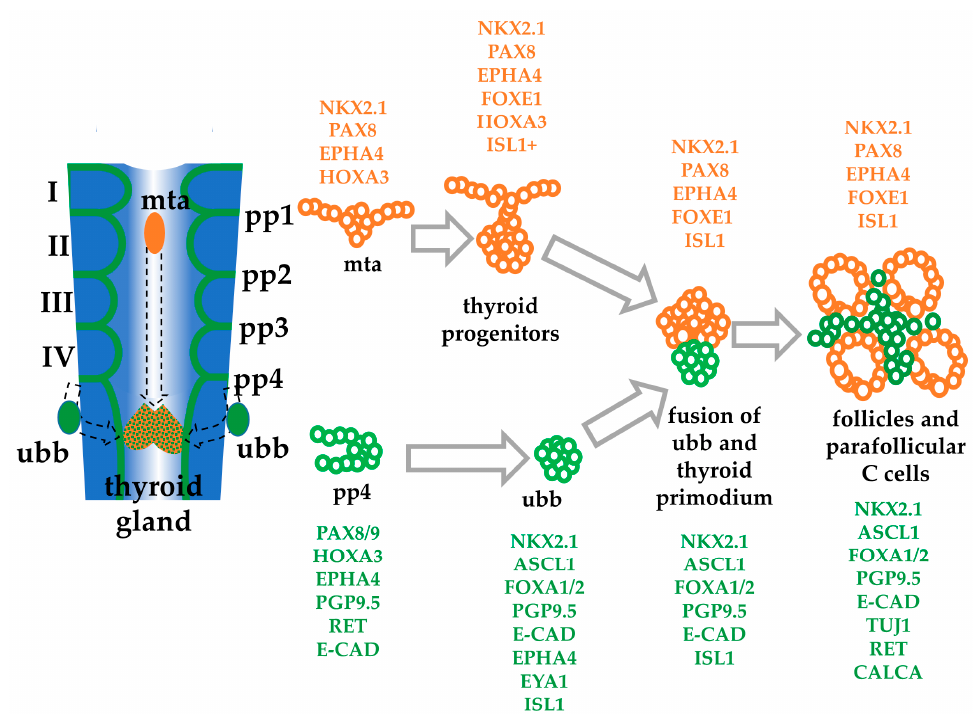
Figure 1. Development of the thyroid organ. Scheme of the development of the pharynx showing the origin and morphogenetic movements of the medial thyroid anlage (mta) from the midventral pharynx, and the ultimobranhial body (ubb) from pharyngeal pouch 4 (pp4). These migrate and fuse to form the follicular and parafollicular C cells, respectively, of the mammalian thyroid gland. These moieties remain separate in other vertebrates. Roman numbers indicate the pharyngeal arches. Key genes are indicated in orange (thyroid follicular cell differentiation) and green (thyroid parafollicular C cell differentiation)